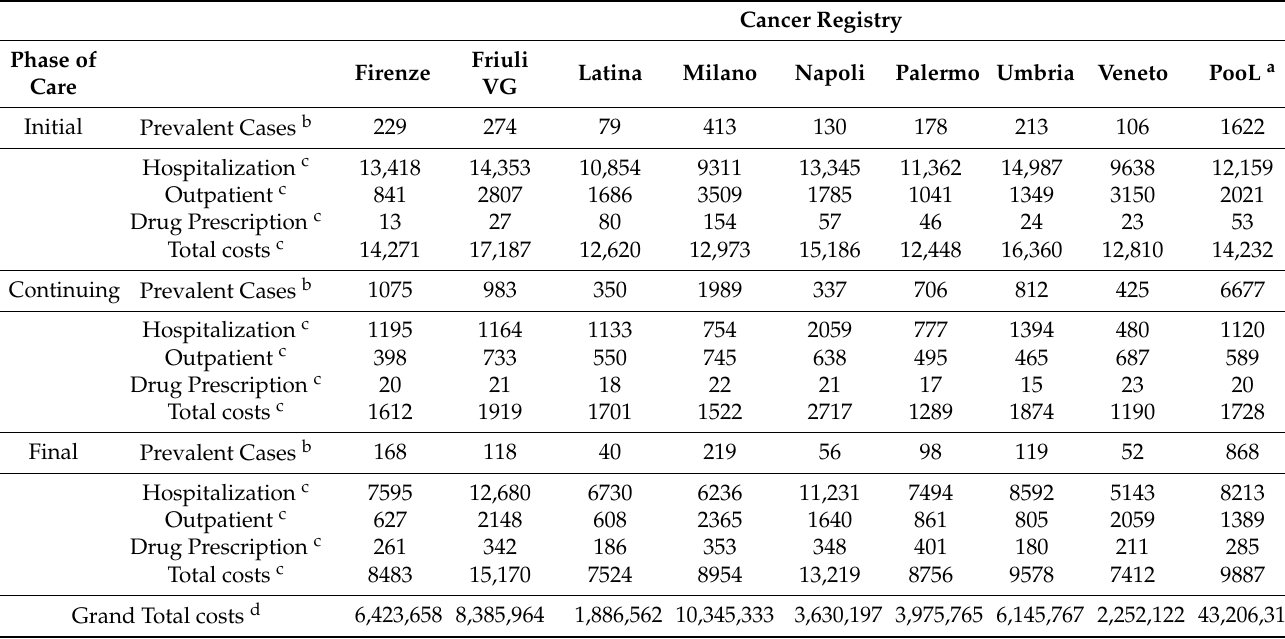
Table 3. Prevalent cases by CR and phase of care and patient annual average costs by CR, type of service and phase of